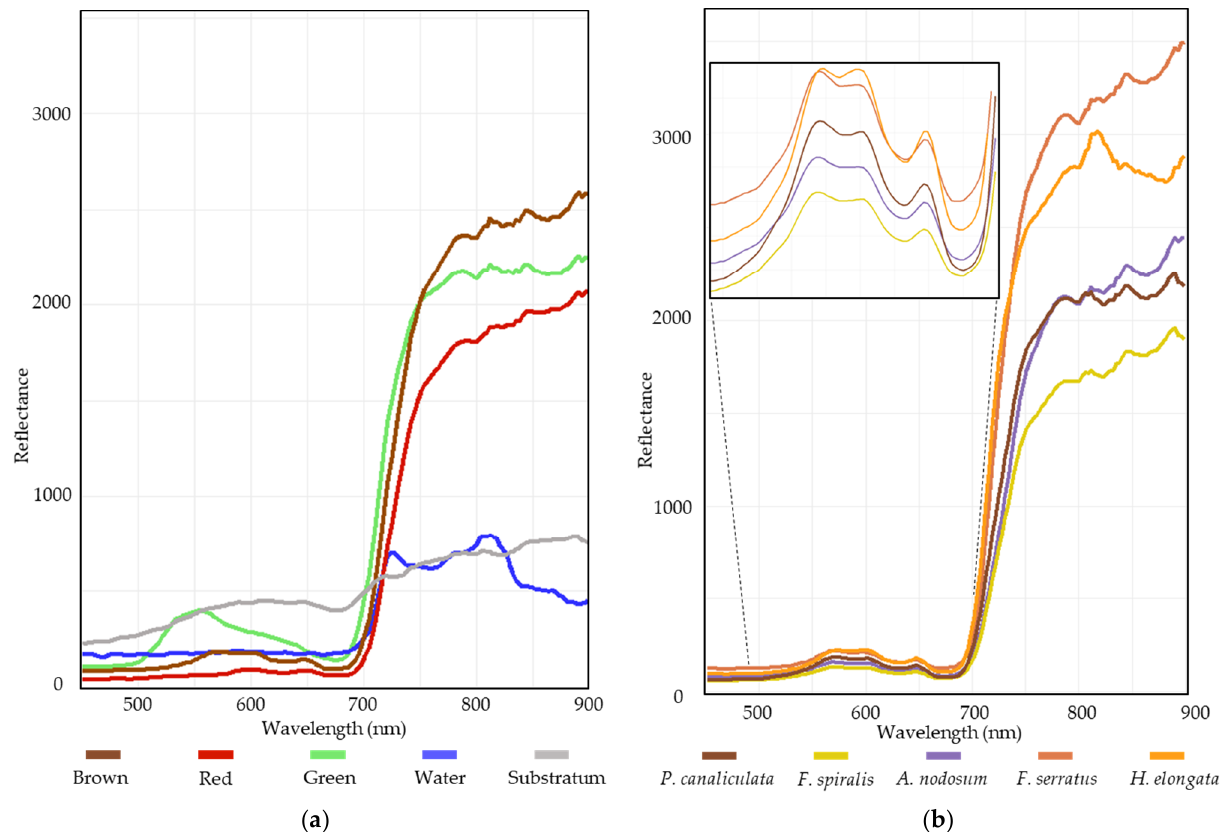
Figure 6. Average reflectance of the different spectral classes between 450 and 900 nm: ( a ) macroalgal groups, water and substratum mean reflectance; ( b ) detailed spectra of each Fucales.